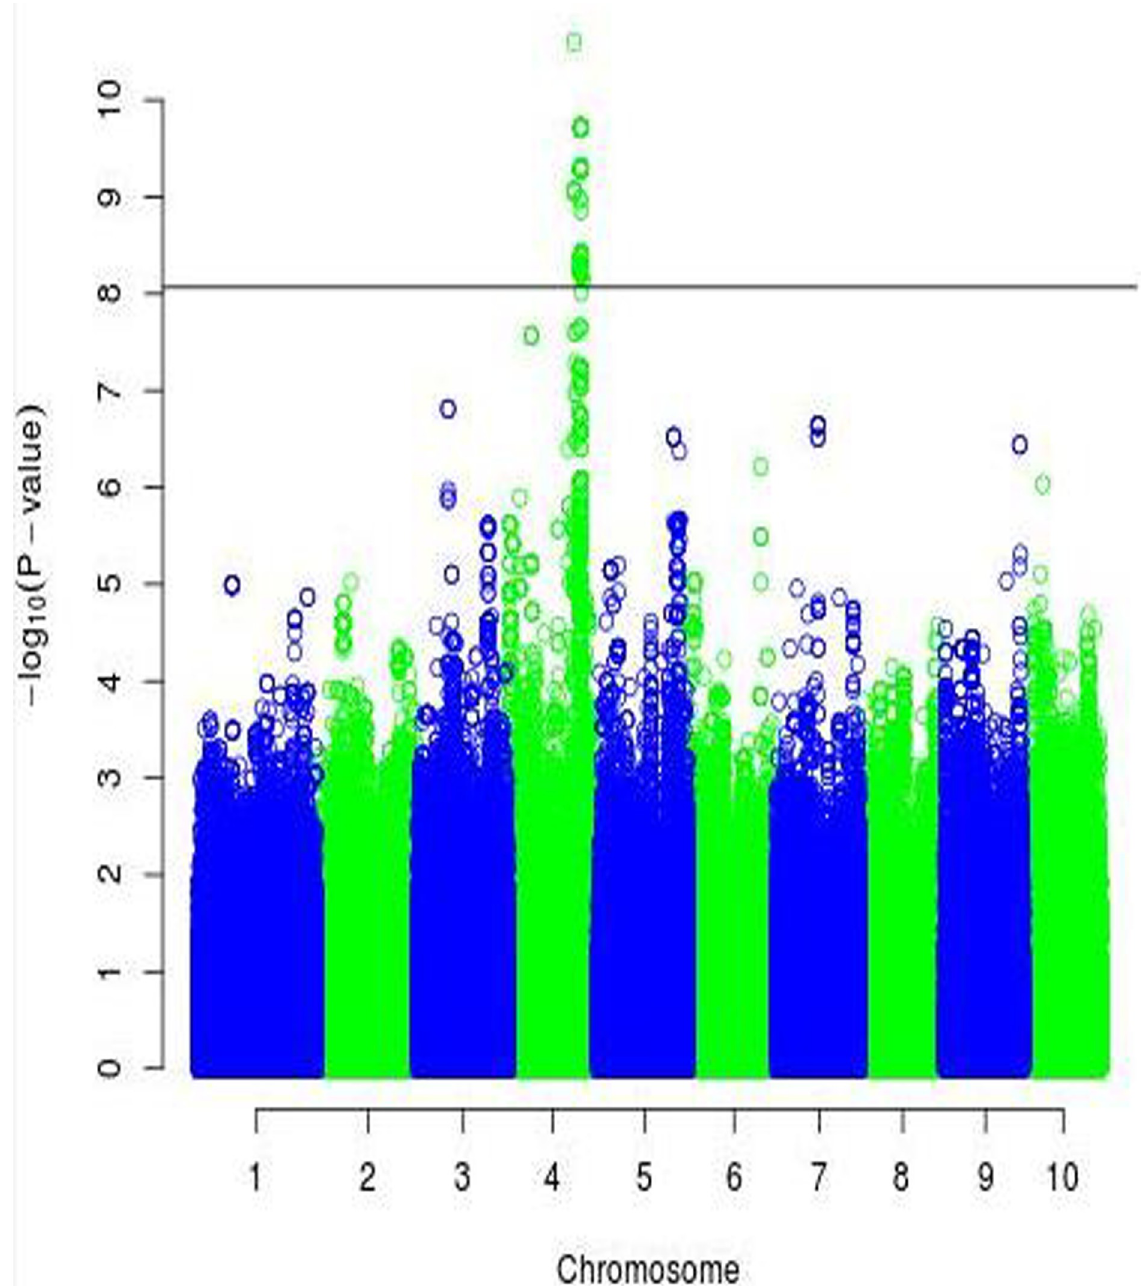
Fig 3. Manhattan plot of -log10 (p) for the region associated with the width of hind leg. The horizontal line represents the assigned threshold of significance. We found only one SNP ( chr5 : 91327124 ) in BTA5 chromosome associated with the cir- cumference of hind leg, (p = 1.23 x 10 − 9 ). After exploring the region around the SNP, we did not find any candidate genes in close proximity. Even when we tolerated a less stringent threshold, we could not identify any significant SNPs associated with hind leg length.